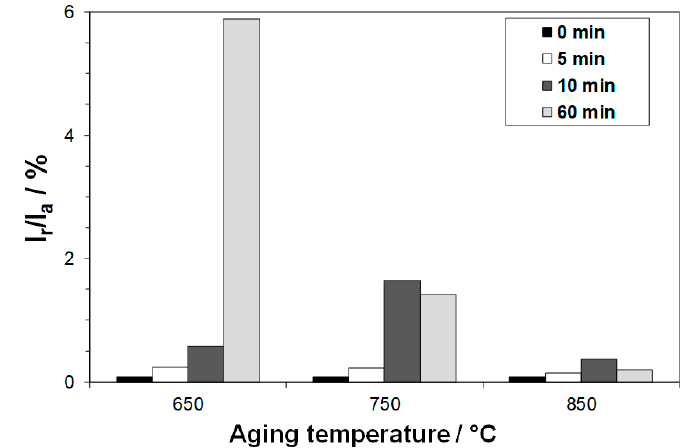
Figure 7. Ir/Ia% determined for as-received and aged DSS 2304, by DL-EPR tests in 33% H 2 SO 4 + 0.45% HCl solution, at 20 °C.